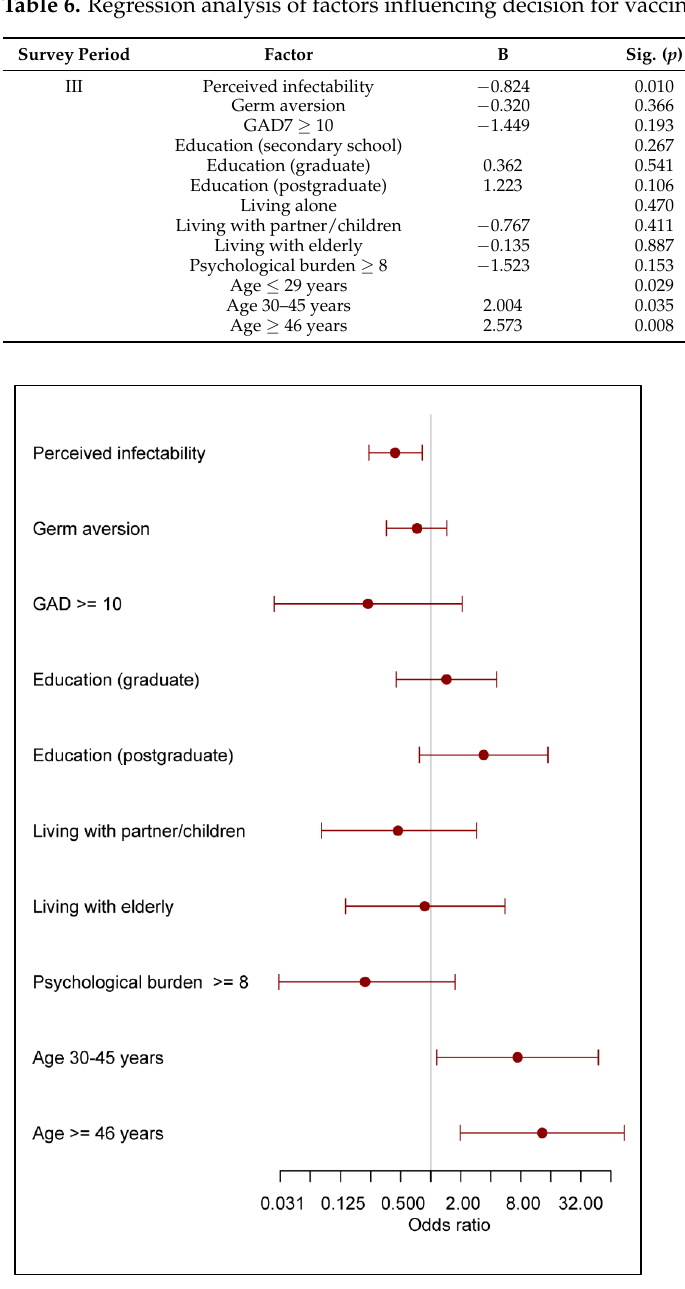
Figure 2. Regression analysis of factors influencing decision for vaccination and vaccination inten- tion in the third survey period. Odds ratios above 1 denote greater proportion of already vaccinated to those still